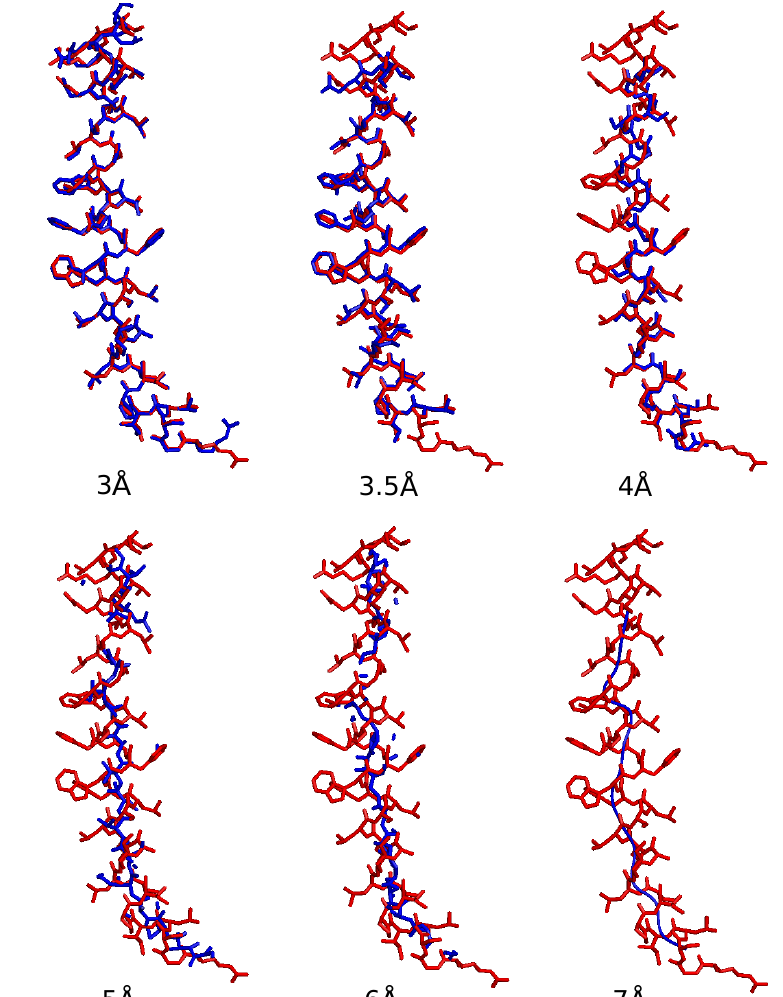
Figure 8. The reconstructed models of 2JLN using the calculated phases of the 3, 3.5, 4, 5, 6, and 7 Å observed data. One major helix is presented for clarity. The PDB deposited model is displayed as red sticks. The reconstructed model is colored in